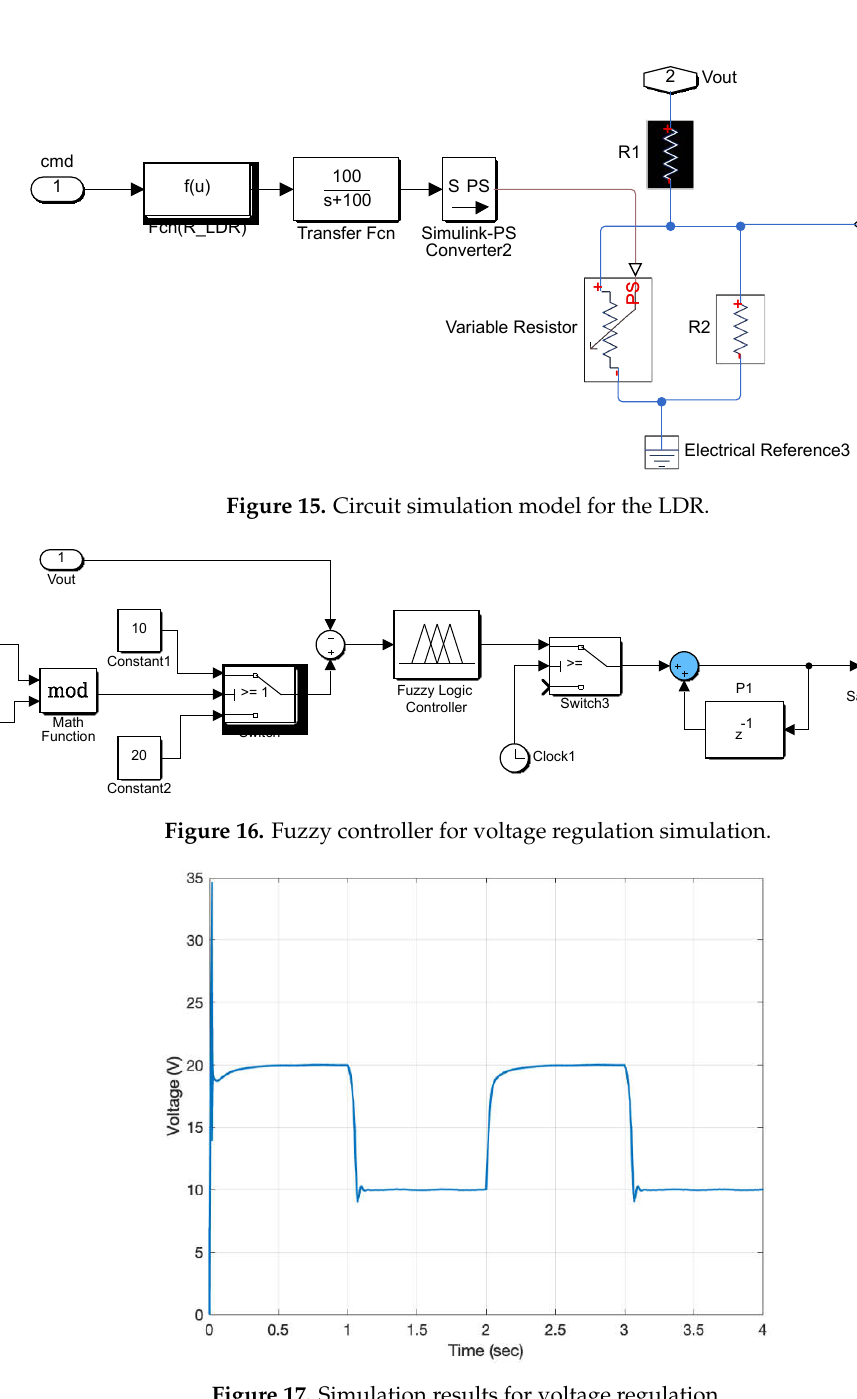
Figure 17. Simulation results for voltage regulation.